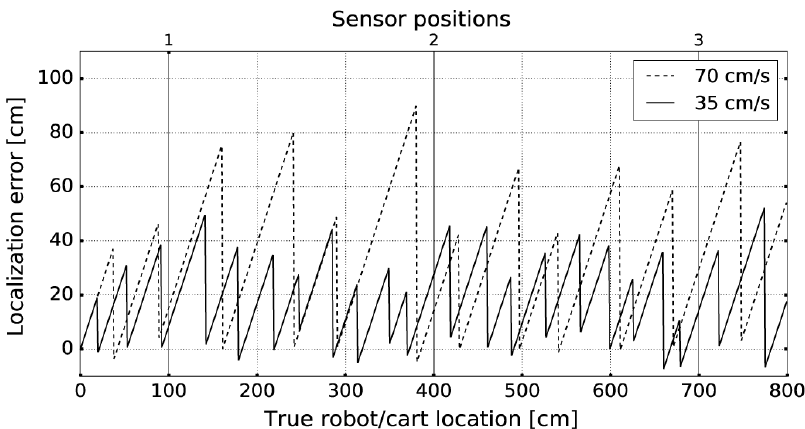
Figure 17. Localization error of the mobile transmitter for two different velocities experimentally measured in the 8-m-long corridor. The height of the sensing nodes was set to 3 m above the transmitter. The transmission delay is uniformly distributed between 0.5 s and 1.5 s. It can be seen that error is significantly and rapidly decreasing after the IR transmission events. Although varying, localization error showed to be bounded below 50 cm for 35 cm / s and below 90 cm for 70 cm / s. The localization error in this context represents a displacement of the estimated location from the real location in 1D (i.e., the displacement on a robot trajectory line); thus, it can be negative.